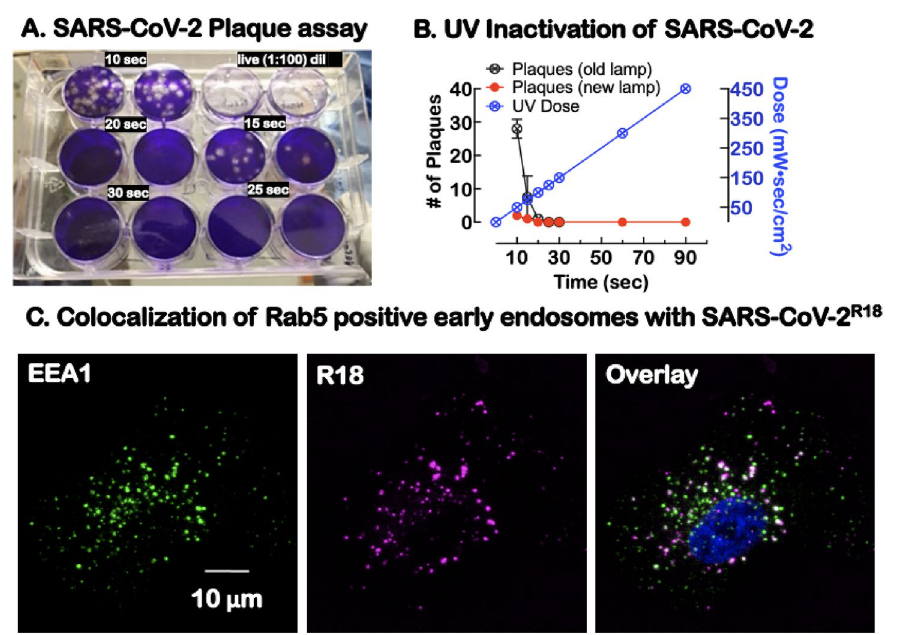
Figure 2. Characterization of UV-inactivated virus for Sars-Cov-2 studies. ( A ) Duplicate plaque assays of supernatants of Sars-CoV-2 exposed to increasing doses of 254 nm radiation and then tested for viability. The live virus completely lysed the cells at 1:100 dilution relative to UV exposed virions. ( B ) Graph shows UV dose– response, leading to a significant decrease in plaque-forming units at different doses. For our experiments, a 90 s (450 mW s/cm 2 ) UV dose was used to inactivate the virus before removal from the BSL-3 laboratory. ( C ) Confocal microscopy imaging of cells after incubation with SARS-CoV-2 R18 (magenta) for 15 min, then fixed and labeled for early endosome marker, early endosome antigen 1 or EEA1 (green), an effector protein for Rab5, and nuclei (Hoechst 33,258, blue). SARS-CoV-2 R18 vesicles are trafficked to the perinuclear region, and a subset is co-localized with EEA1. Images are maximum projections and have been brightness and